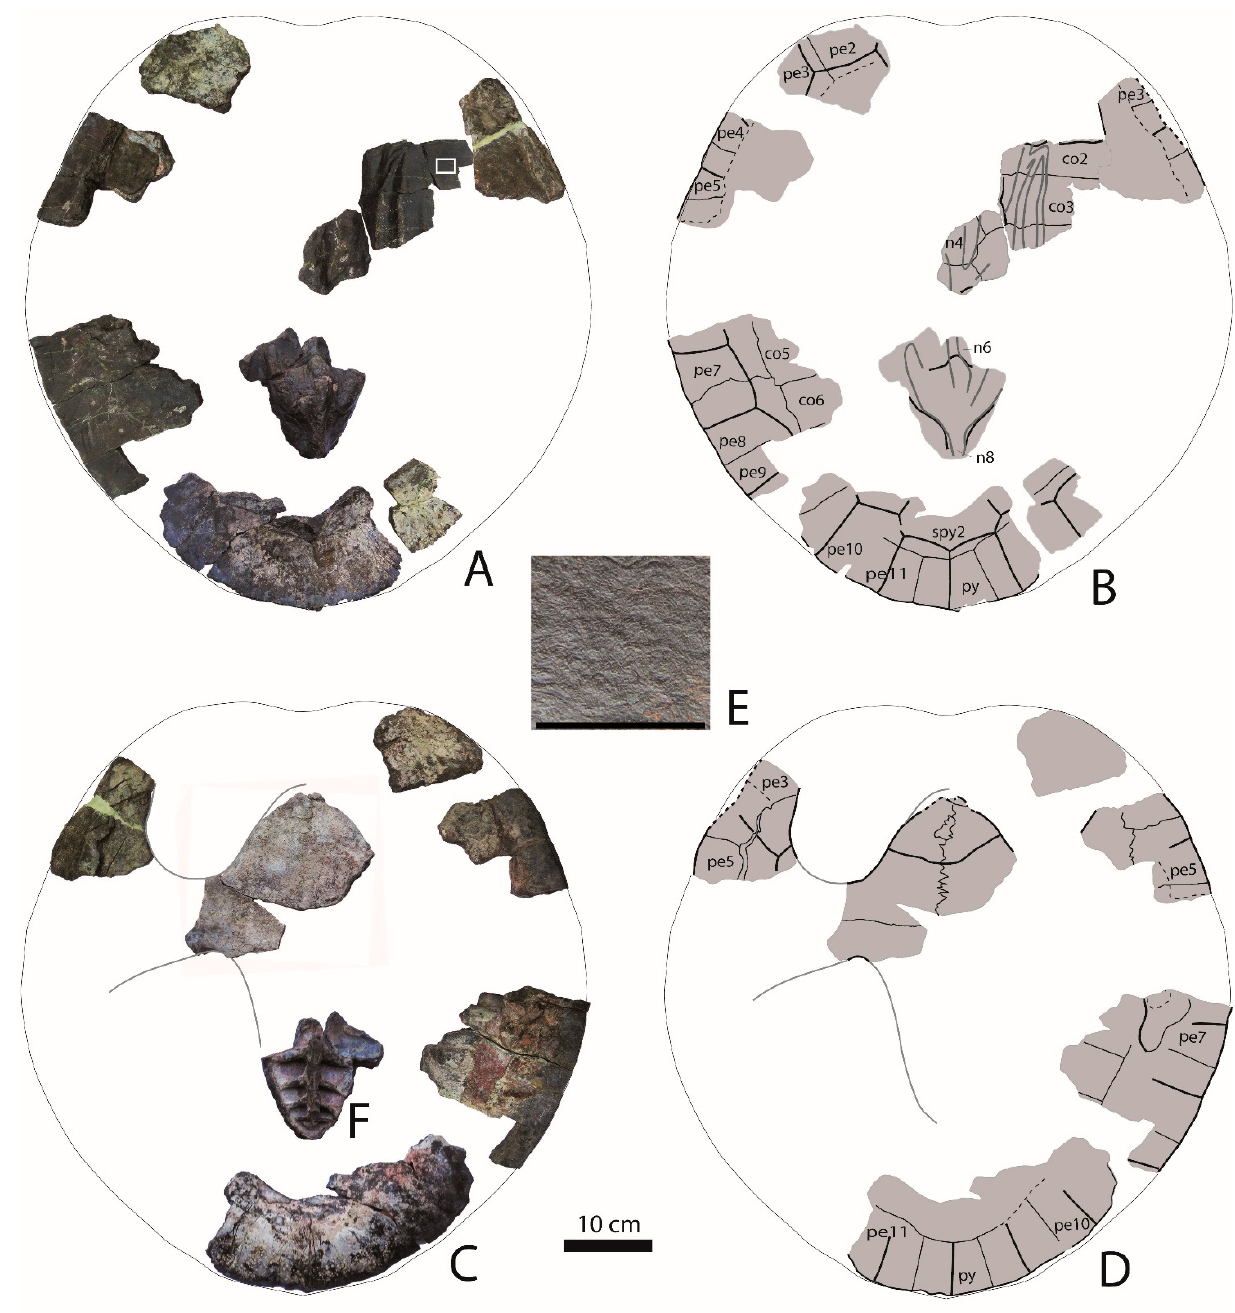
Figure 2. Yakemys multiporcata n. g. n. sp. from the upper part of the Phu Kradung Formation (basal Cretaceous) of Khorat Plateau, NE Thailand. Holotype (SM KS39) from Ban Hui Yang locality, Sam Chai District, Kalasin Province. ( A , B ) Carapace in dorsal view; ( C , D ) shell in ventral view; ( E ) detail of ornamentation of the carapace surface (on costal 2, indicated by a white rectangle on A), and ( F ) neural 6–8 with adjacent costal fragments in ventral view. Scale bar = 10 cm for ( A – D , F ) and 2 cm for ( E ). Abbreviations: co, costal plate; Ma, marginal scute; n, neural plate; pe, peripheral plate; py, pygal plate; spy, suprapygal plate; V, vertebral scute.